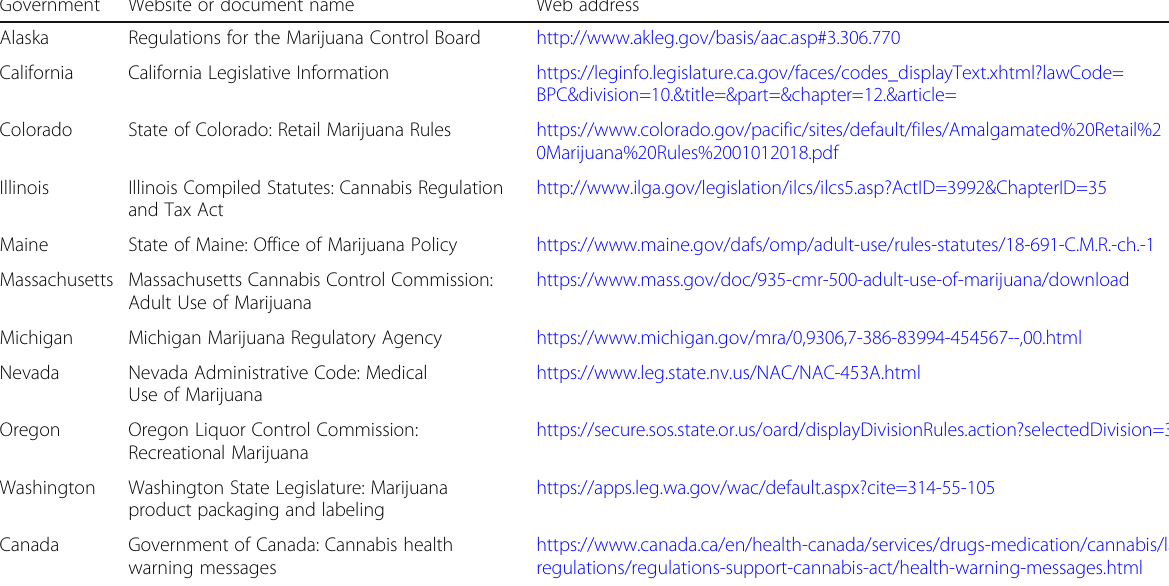
Table 2 Sources of government-mandated warnings on packages of cannabis legally sold for recreational use Government